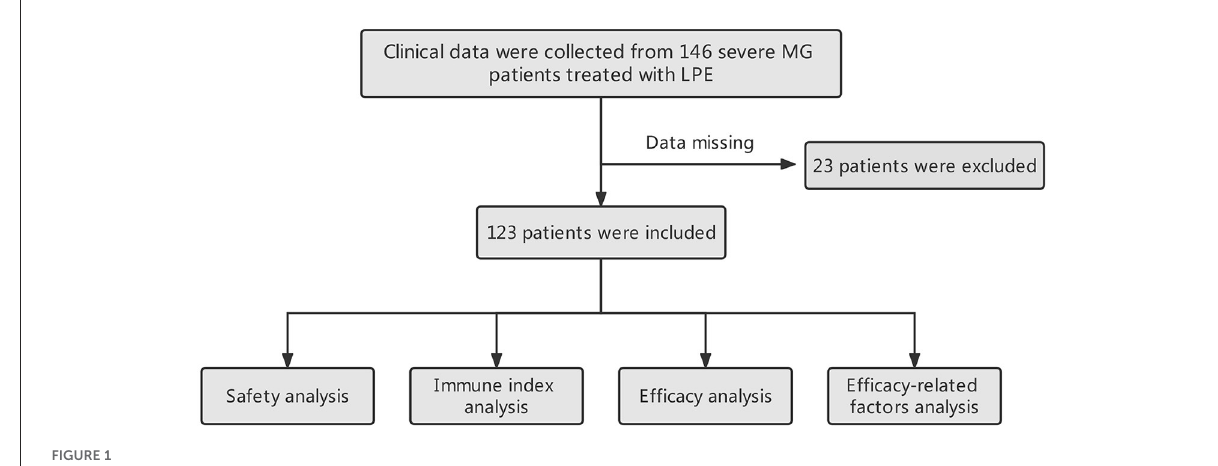
FIGURE1 The flowchart designed for this study.